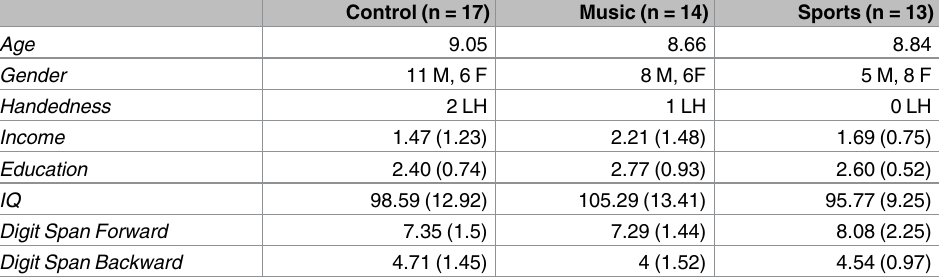
Table 1. Participant